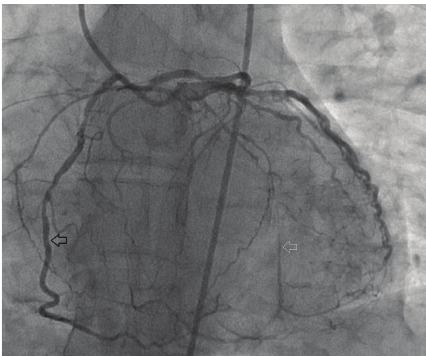
Figure 6: Right coronary artery from proximal left anterior descending coronary artery (black arrow) and retrograde filling of circumflex coronary artery (white arrow).